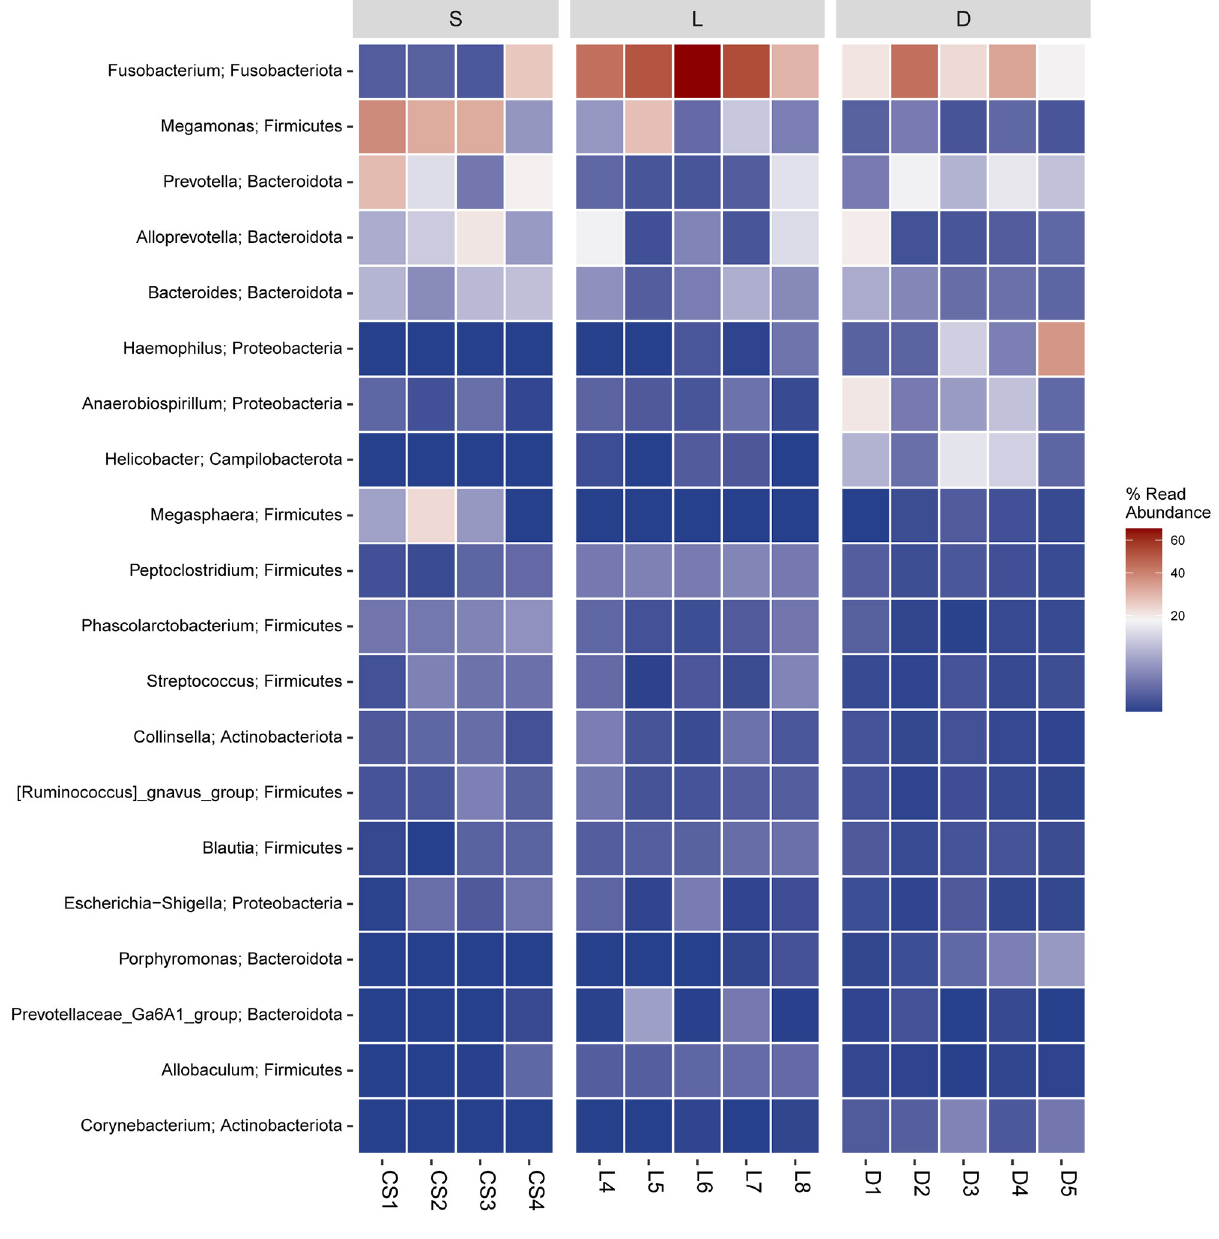
FIGURE 7 | Heatmap of hierarchy cluster results for the abundance of genus. The genus names of the OTUs are shown on the left, and the different colors of the spots indicated the normalized and log-transformed relative